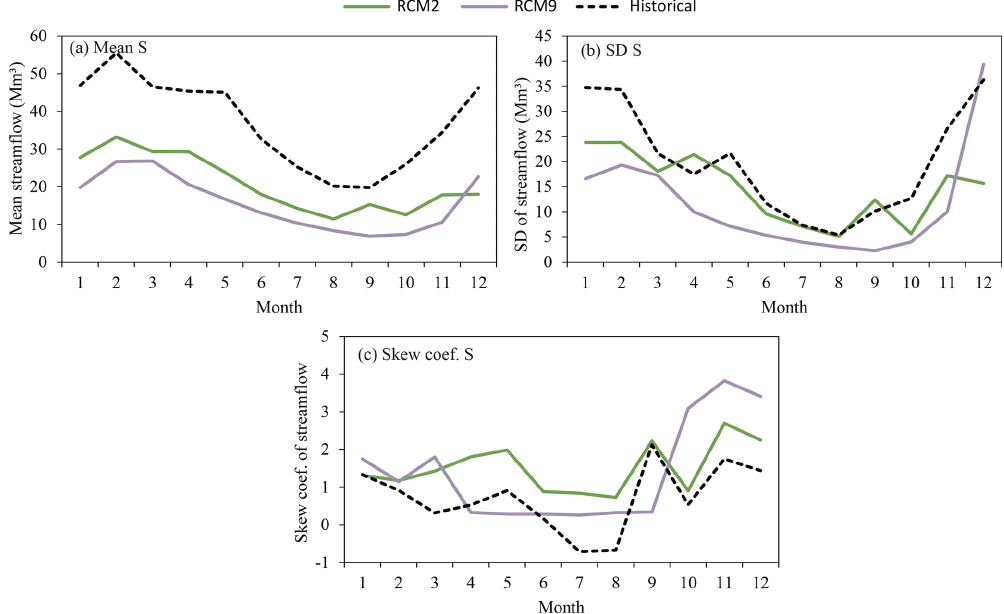
Figure 11. Monthly mean (a) , standard deviation (b) and skew coefficient (c) within the mean year of the historical period (1972–2002) and future horizon (2071–2100) series (RCM2 and RCM9) for streamflow.